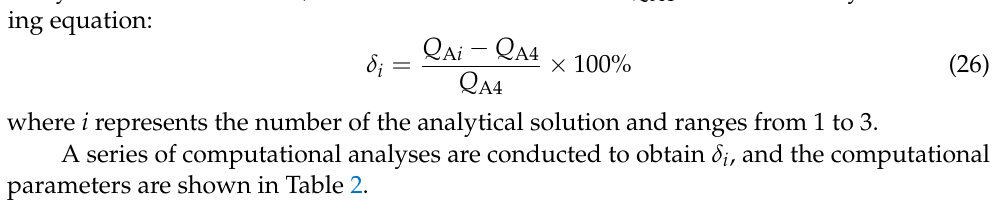
Table 2. Parameters of computational analyses.